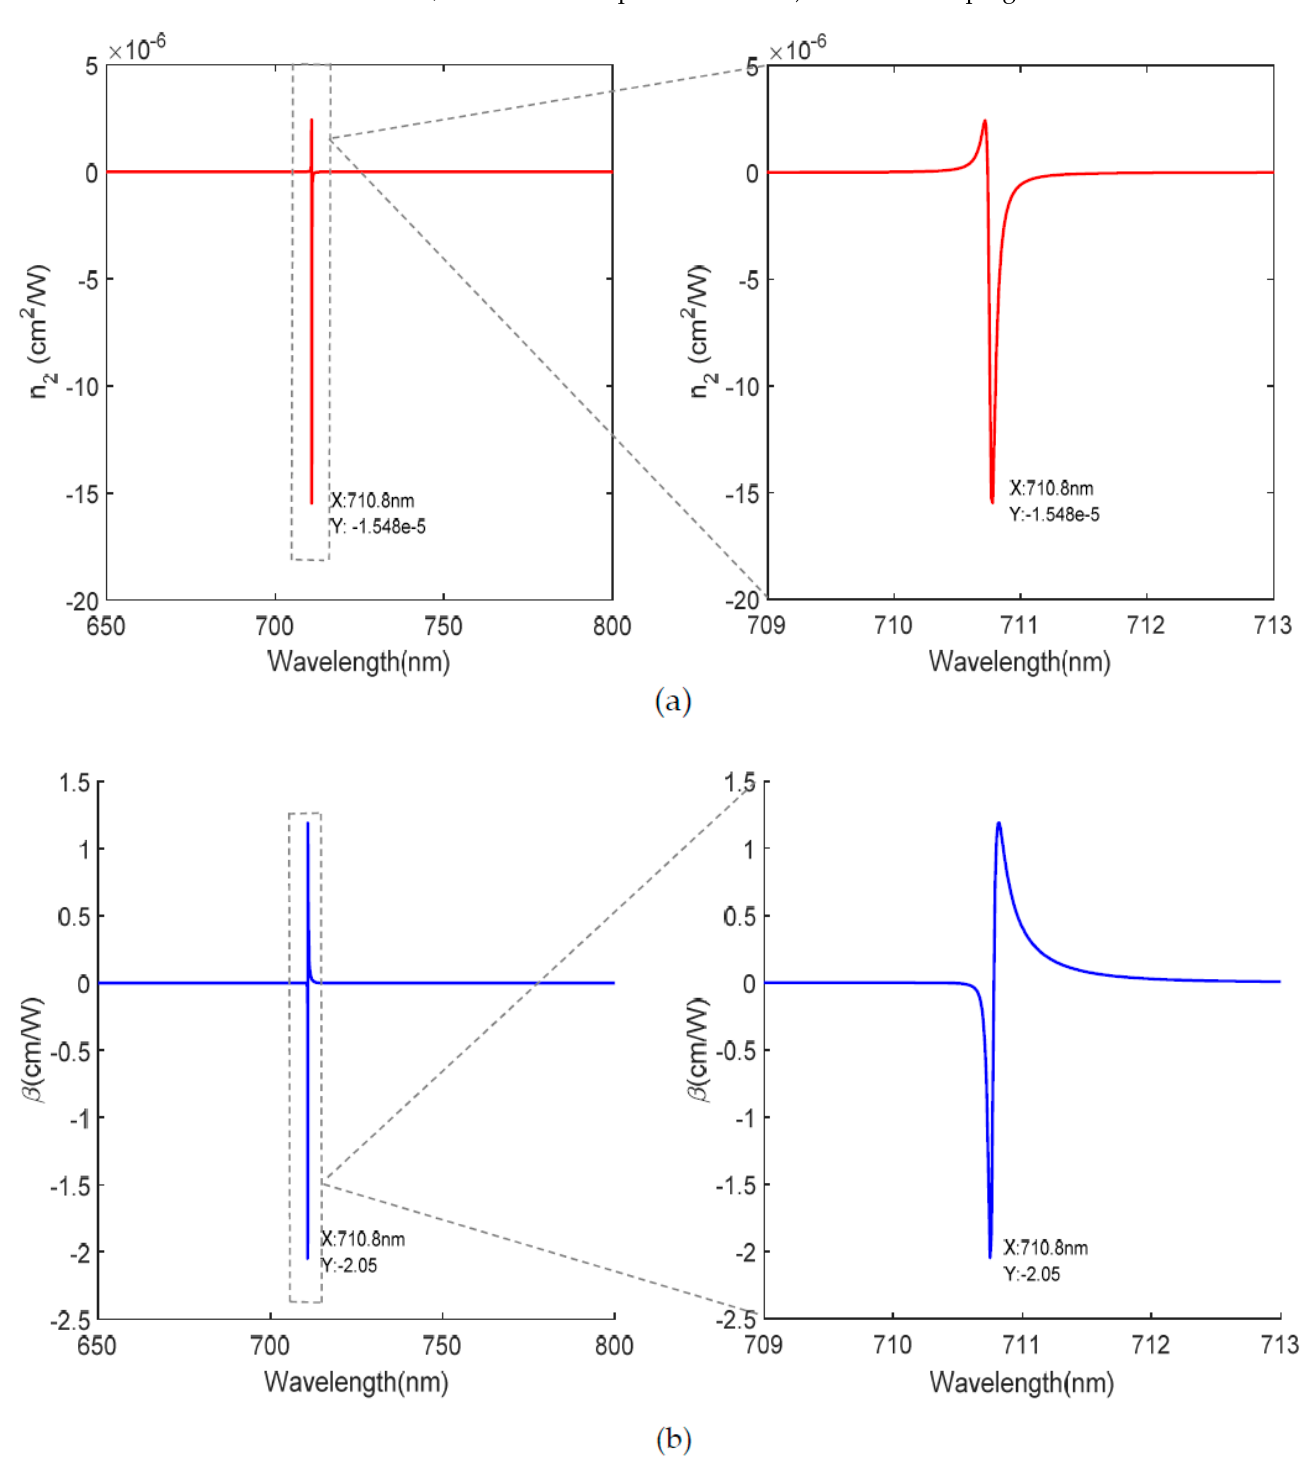
Figure 10. Nonlinear coefficient with the gain medium. ( a ) Nonlinear refraction index n 2 . ( b ) Nonlinear absorption coefficient β